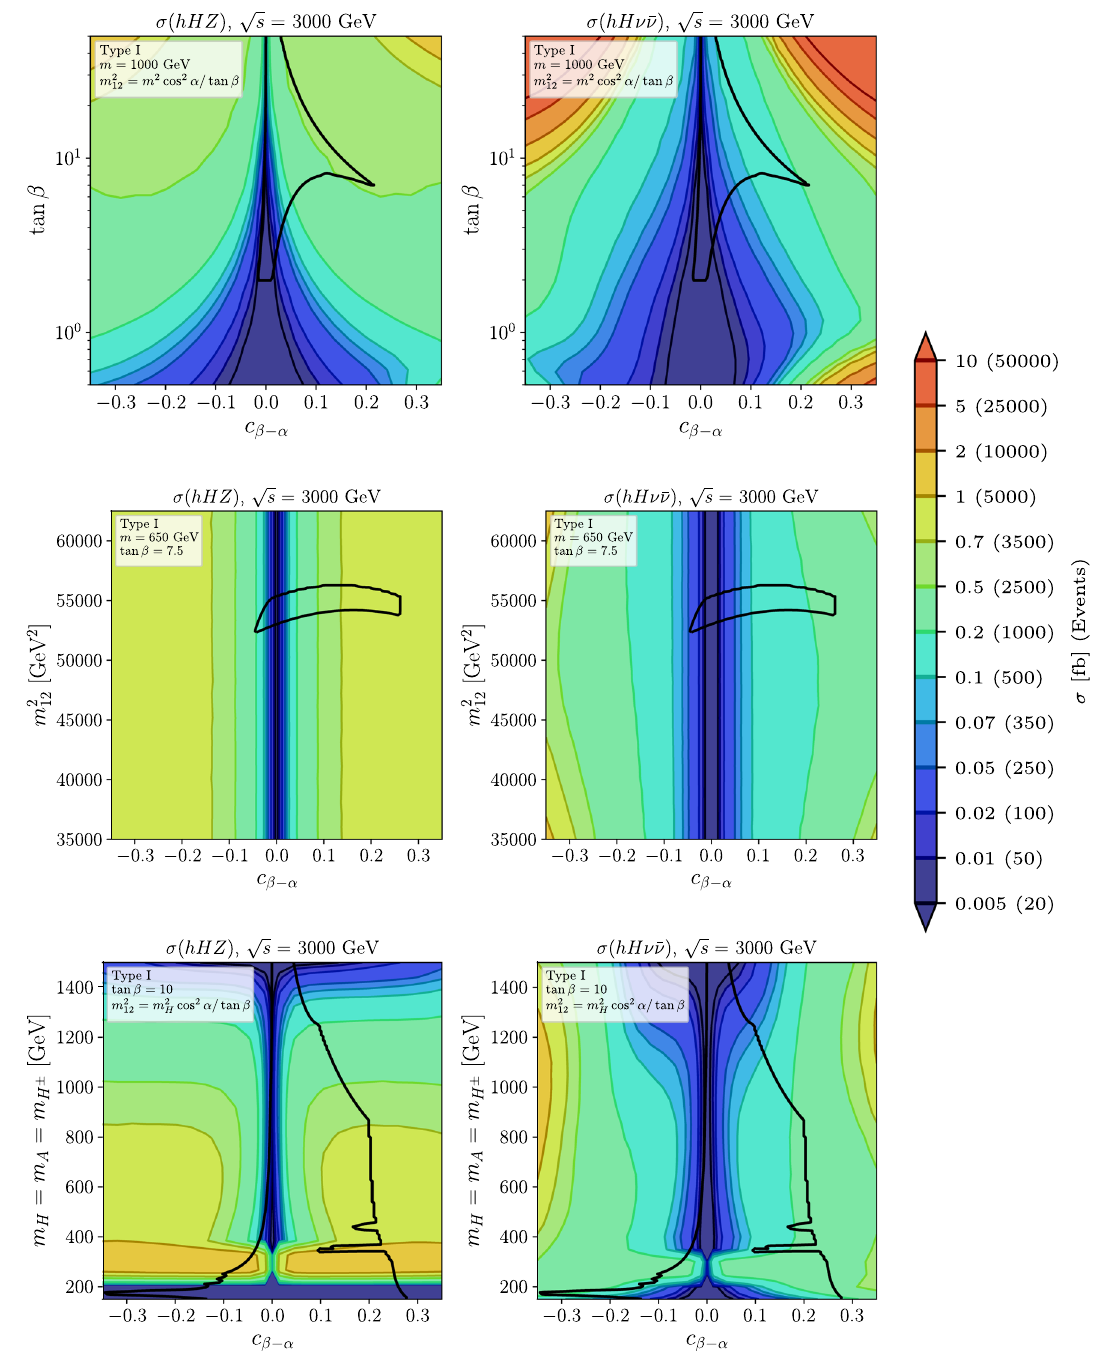
√ s = 3000 GeV for the benchmark planes 1-3 (top to bottom).